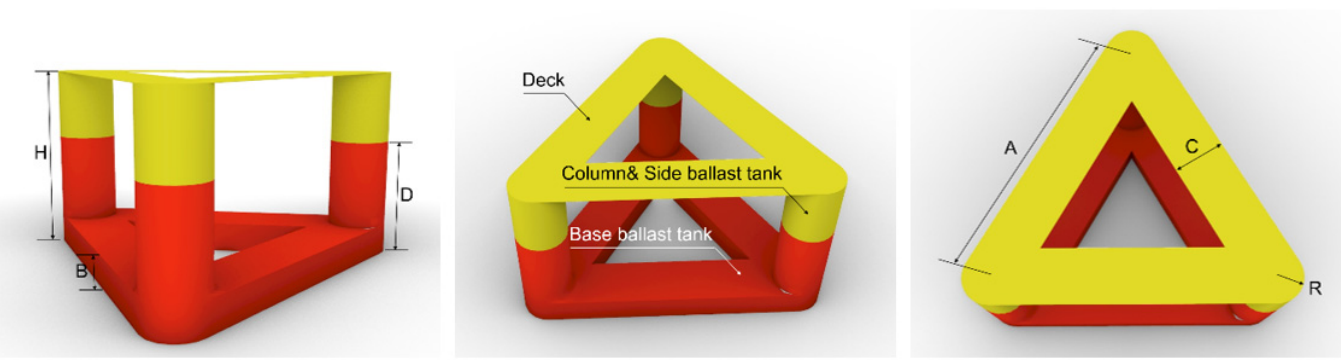
Figure 8. Name of the part and the parameters of the designed platform. The column radius was selected based on the reference range of the amount of material compared with the reference platform design. The platform design presented in this paper was determined by selecting the radius of the column according to the procedure shown in Figure 9.